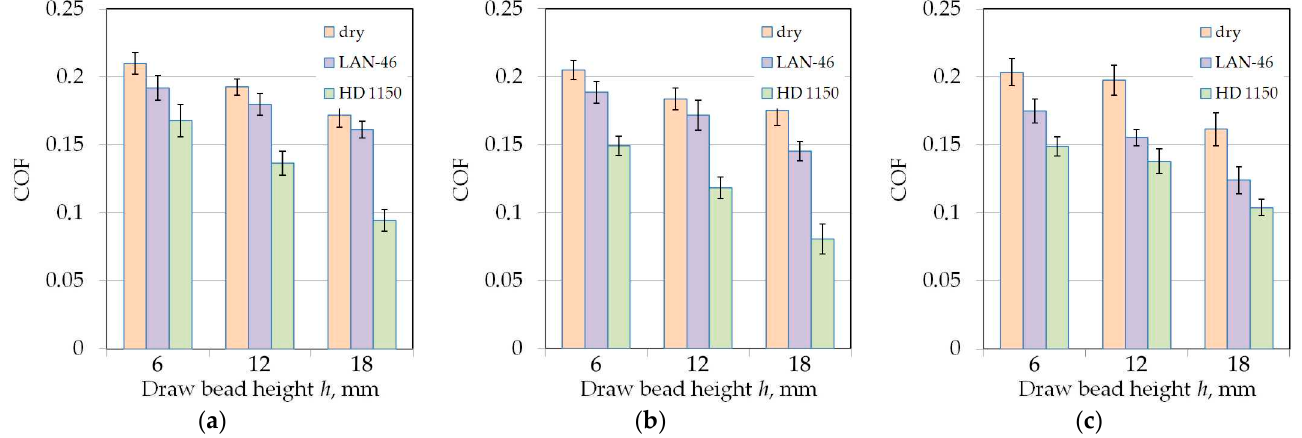
Figure 16. The effect of friction conditions on the value of COF for specimens cut along the sheet rolling direction (orientation 0°) tested using countersamples with a surface roughness of Ra = 0.32 μ m: ( a ) w = 7 mm, ( b ) w = 14 mm, ( c ) w = 20 mm.